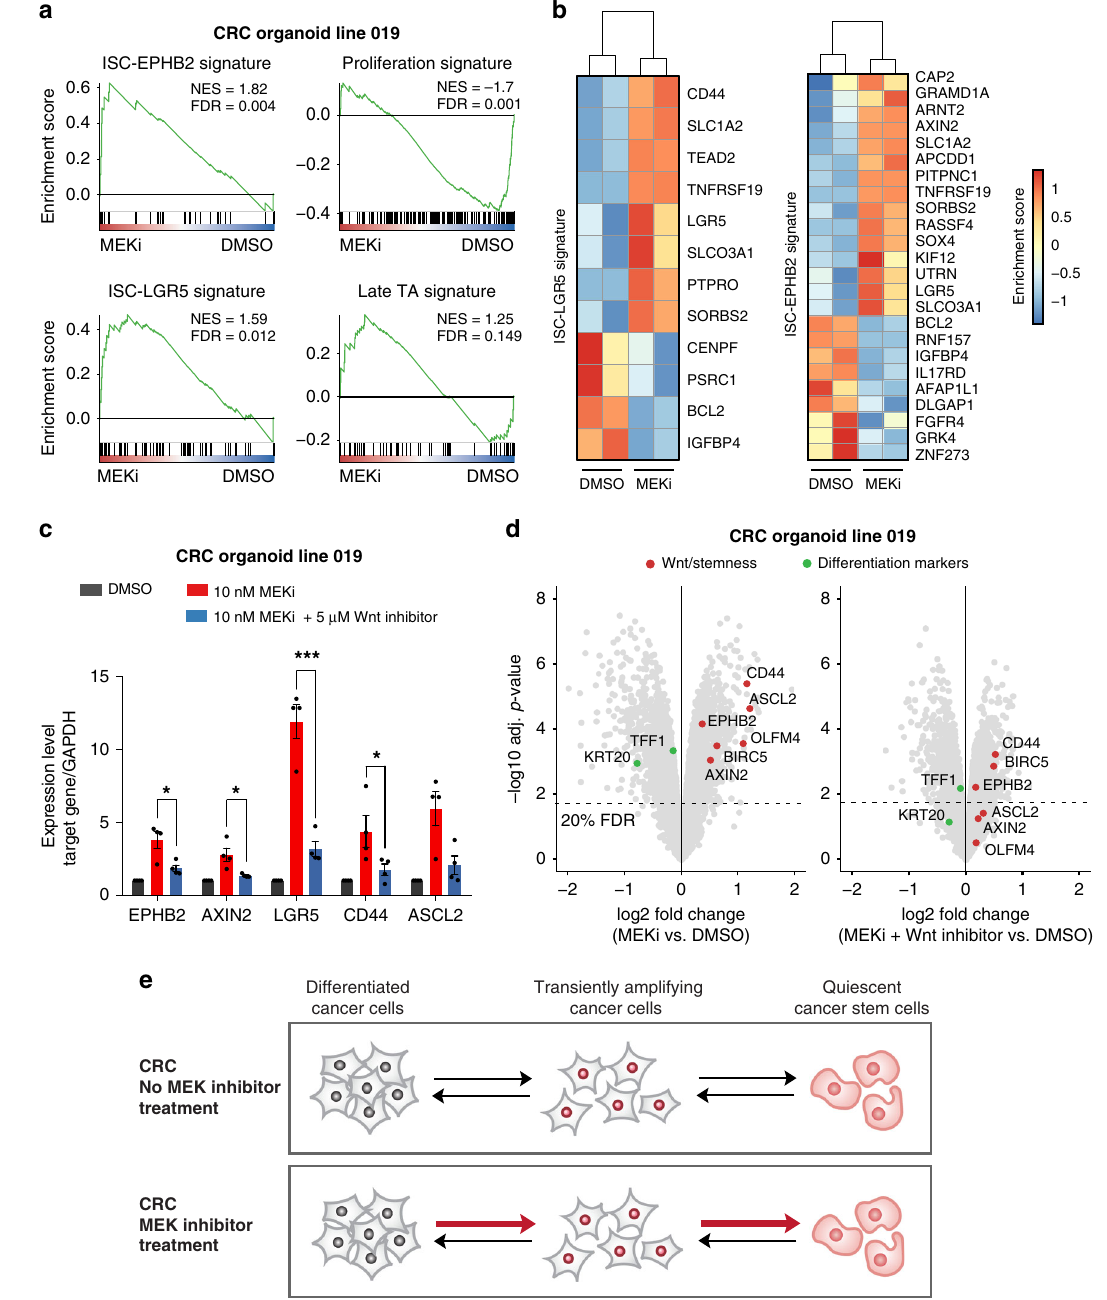
Fig. 8 MEK inhibition induced stemness signatures are associated with CRC relapse. a – b Trametinib treatment induces expression signatures in human colon cancer organoids associated with intestinal stemness. Colorectal cancer organoids were treated for 72 h with trametinib and the global expression pattern was determined by microarray. Transcriptome data of treated human colon cancer organoids were analysed for enrichment of three previously described gene signatures by gene set enrichment analysis (GSEA). b Heatmap depicting the fold-change of individual genes within the humanised ISC- LGR5 and the ISC-EPHB2 gene signature. Data from two biological replicates are shown. c – d Co-treatment of colon cancer organoids with Wnt inhibitor PRI-724 abolishes the trametinib induced Wnt and stemness activation. c Human colorectal cancer organoids were treated with 10 nM of trametinib and 5 μ M of the Wnt inhibitor PRI-724. Expression of selected Wnt target and stemness genes was analysed by qPCR. The effect of co-treatment on an additional CRC organoid line is shown in Supplementary Fig. 8. Data from four independent experiments are represented as mean ± s.e.m. * p < 0.05, *** p < 0.001, two-sided Student ’ s t -test. d Human colorectal cancer organoids were treated with 10 nM of trametinib and 10 μ M of the Wnt inhibitor PRI-724. Global expression was measured by microarray. Data from two independent experiments are shown. e Model of MEK inhibition induced Wnt-activation. Inhibition of the MEK1/2 leads to activation of Wnt signalling and intestinal stemness signatures. This change of signalling networks results in the induction of cellular plasticity and reprogramming of differentiated cancer cells into cancer stem